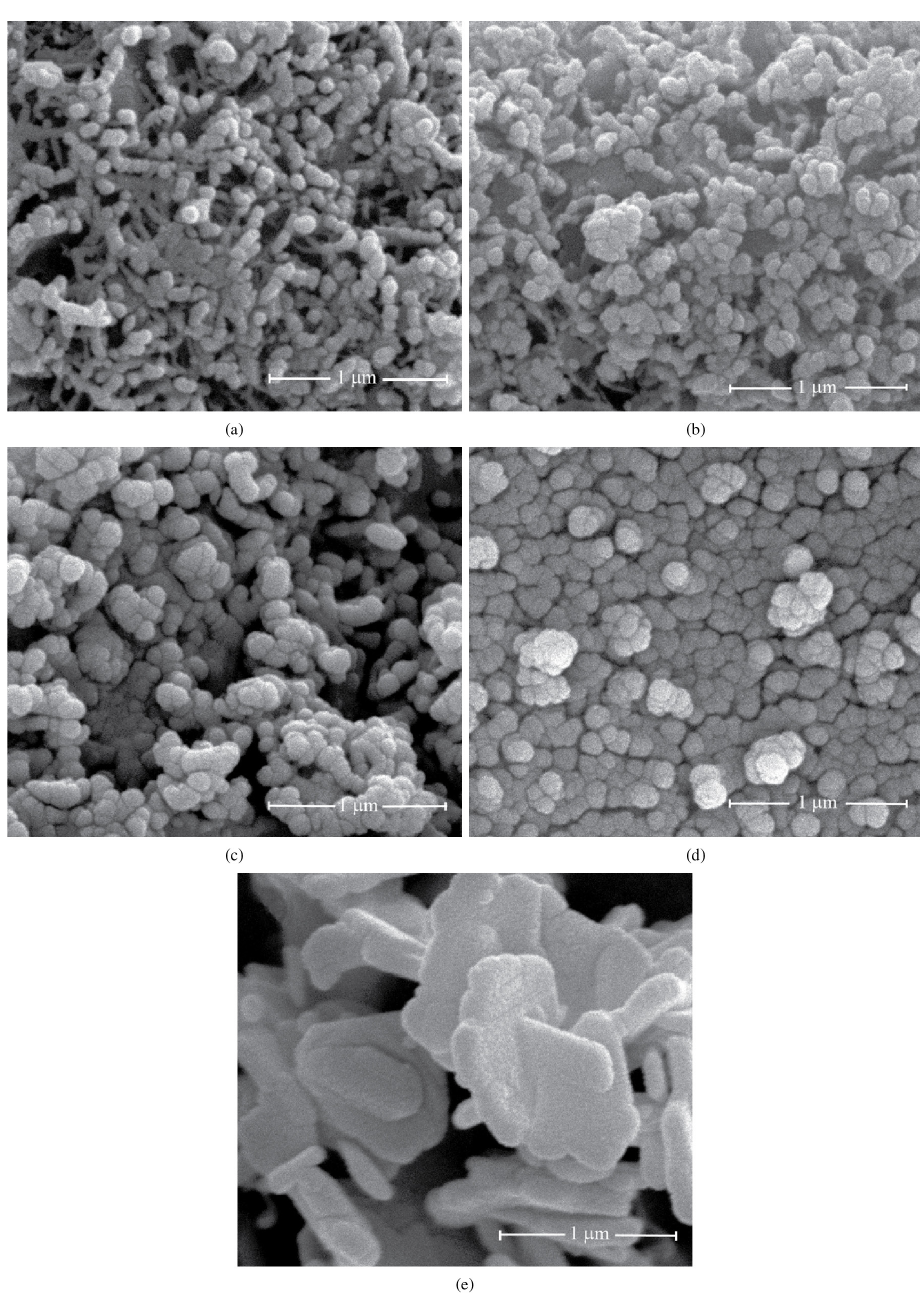
Figure 2. SEM micrographs of samples: (a) F1, (b) F2, (c) F3, (d) F4 and (e)